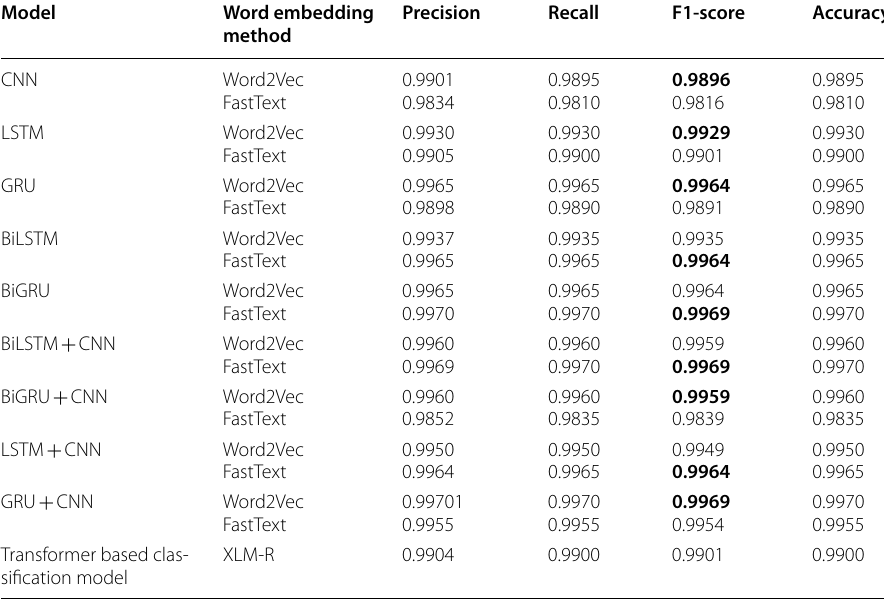
The numbers in bold represent the highest F1‑score obtained for each